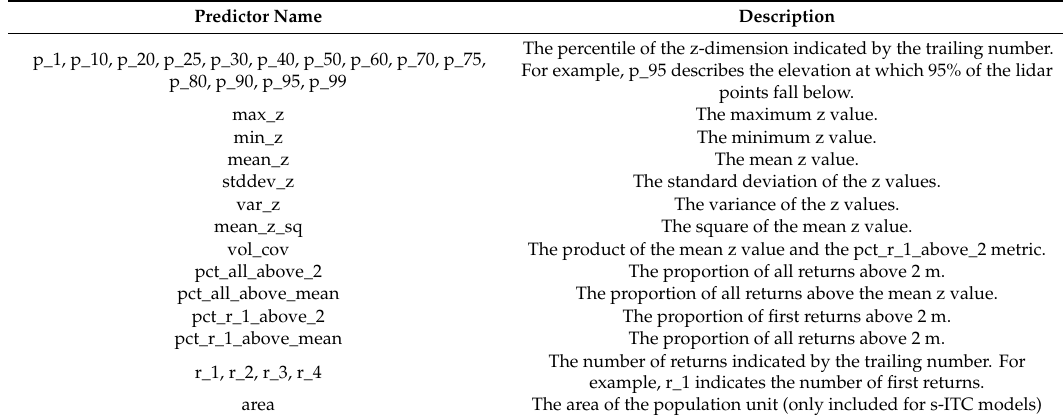
Table A2. Descriptions of lidar predictors considered for ABA and s-ITC